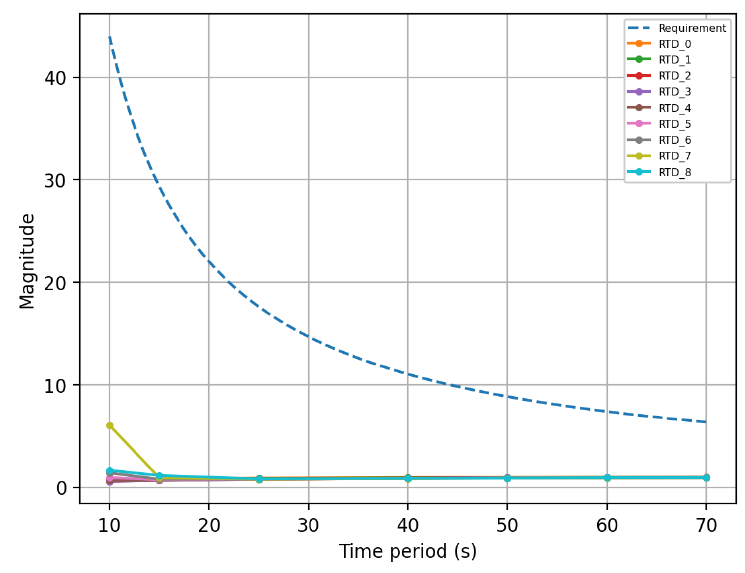
Figure 12. Aggregated plots showing the impact of injected latency to FCR dynamic performance.